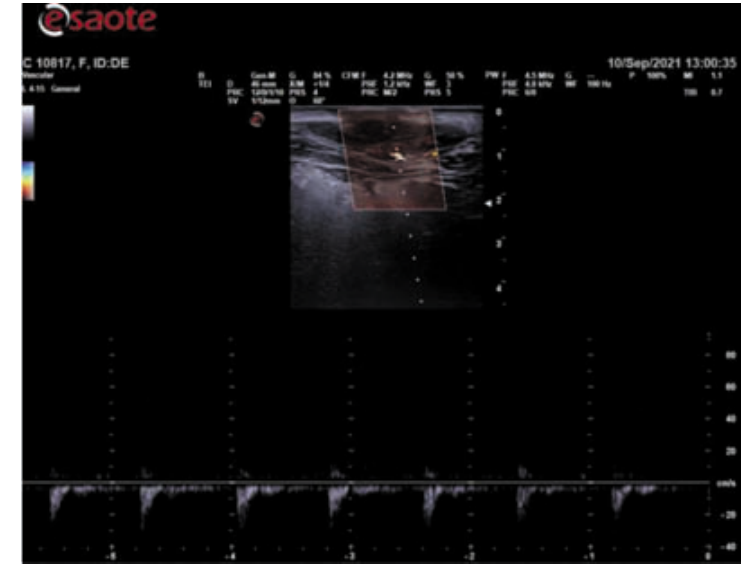
Fig. 1 Pulsed wave Doppler, power Doppler and B-mode ultrasound image of ventral perineal artery in femail dogs during dioestrum.